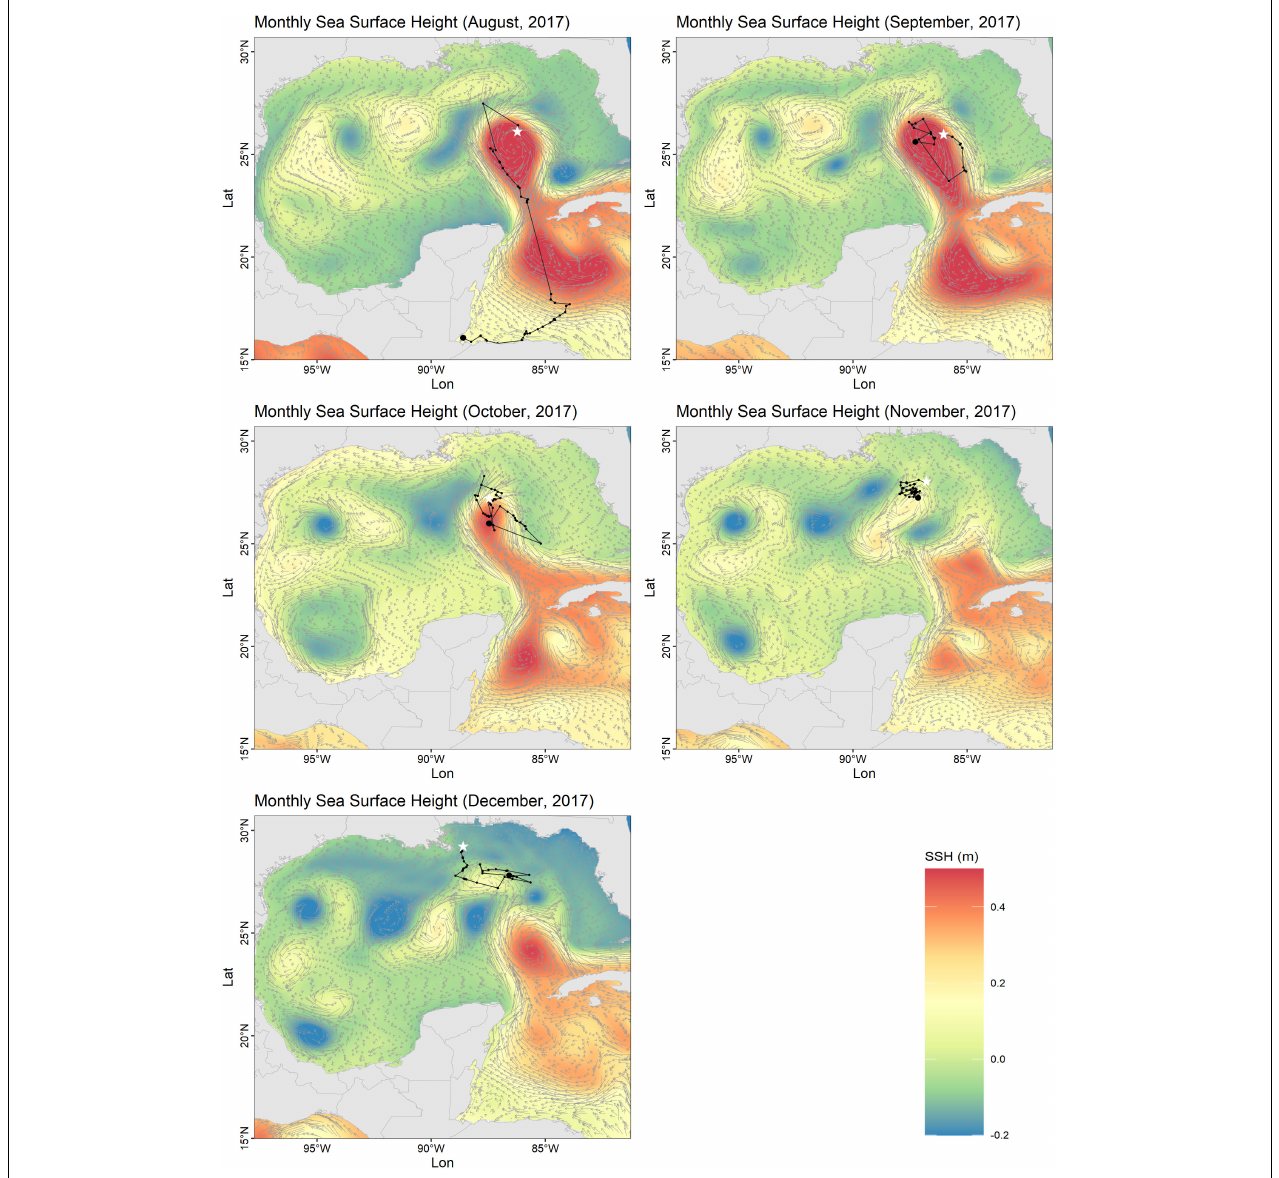
FIGURE 2 | Monthly means of sea surface height (SSH) and ocean current velocity vectors produced by Copernicus Marine Environment Monitoring System (CMEMS) (Copernicus Marine Environment Monitoring Service [CMEMS], 2020) during the oceanic movement of a male hawksbill ( Ei 5) from September to December 2017. Current direction and speed are represented by gray arrows and the sea turtle tracks are plotted as black dots and lines. Largest black dots are the start of the mapped tracking period and white stars the